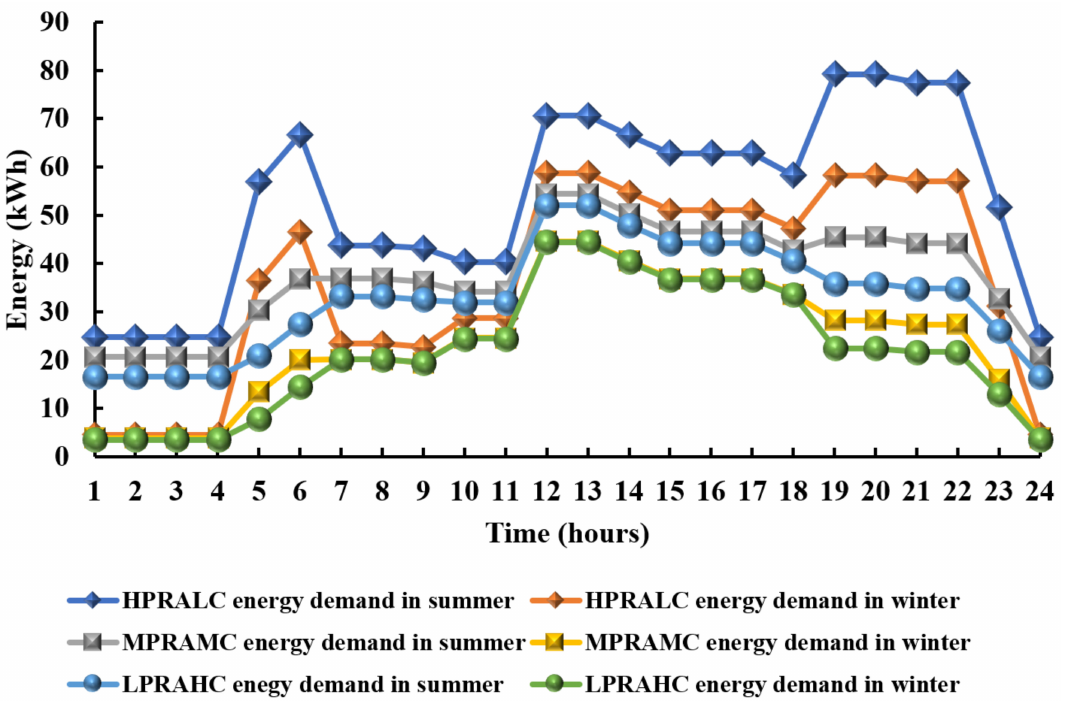
Figure 3. Hourly energy demands for all the efficient appliance usage-based scenarios in winter and summer seasons.